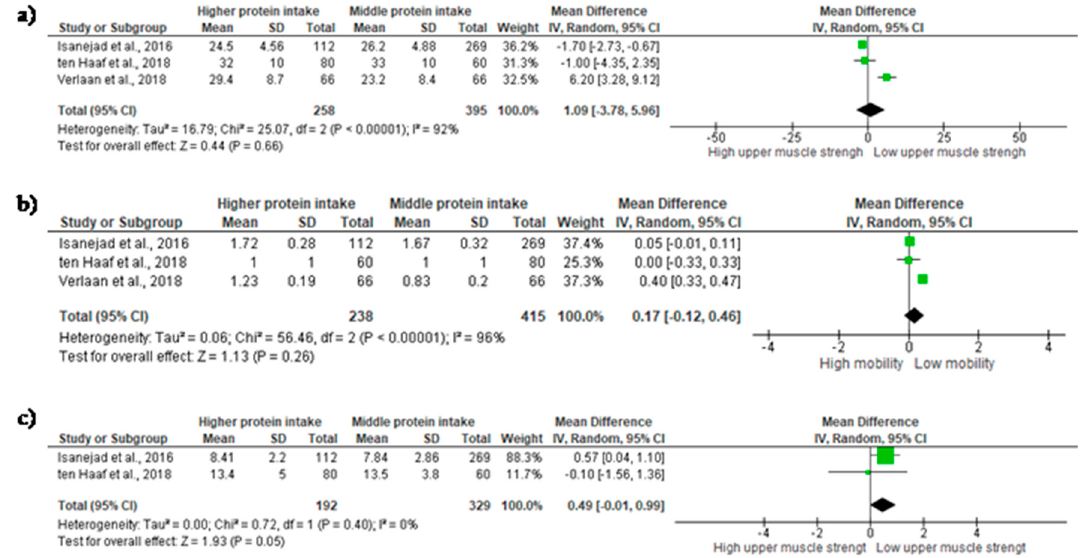
Figure 3. Mean differences in Mobility according to protein intake. ( a ) Chan et al., 2014, and Isanejad et al., 2016; ( b ) Chan et al., 2014b, and Isanejad et al., 2016; ( c ) Chan et al., 2014ab, and Isanejad et al., 2016; ( d ) Chan et al., 2014c, and Isanejad et al., 2016; ( e ) Chan et al., 2014abc, and Isanejad et al., 2016. Squares represent study-specific estimates; diamonds represent pooled estimates of random-effects meta-analyses.